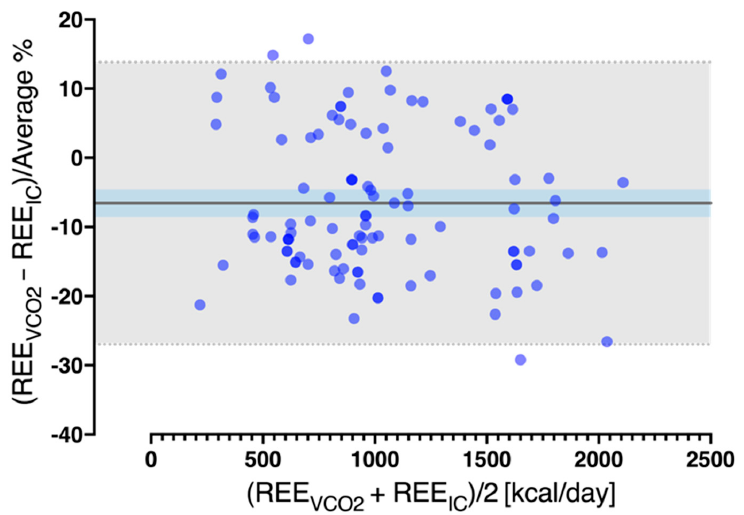
Figure 2. Bland–Altman plot whereby resting energy expenditure (REE) based on volumetric carbon dioxide production (VCO 2 ) measurements (REE VCO2 ) alone is compared to REE measured by IC (REE IC ) at ICU Day-1. The solid line indicates the percentage of agreement bias (%), and the light shade with the fine dotted lines indicates the limits of agreement (bias ± (1.96 × SD) = precision). Dark shade represents the 95% confidence intervals of the mean (bias).